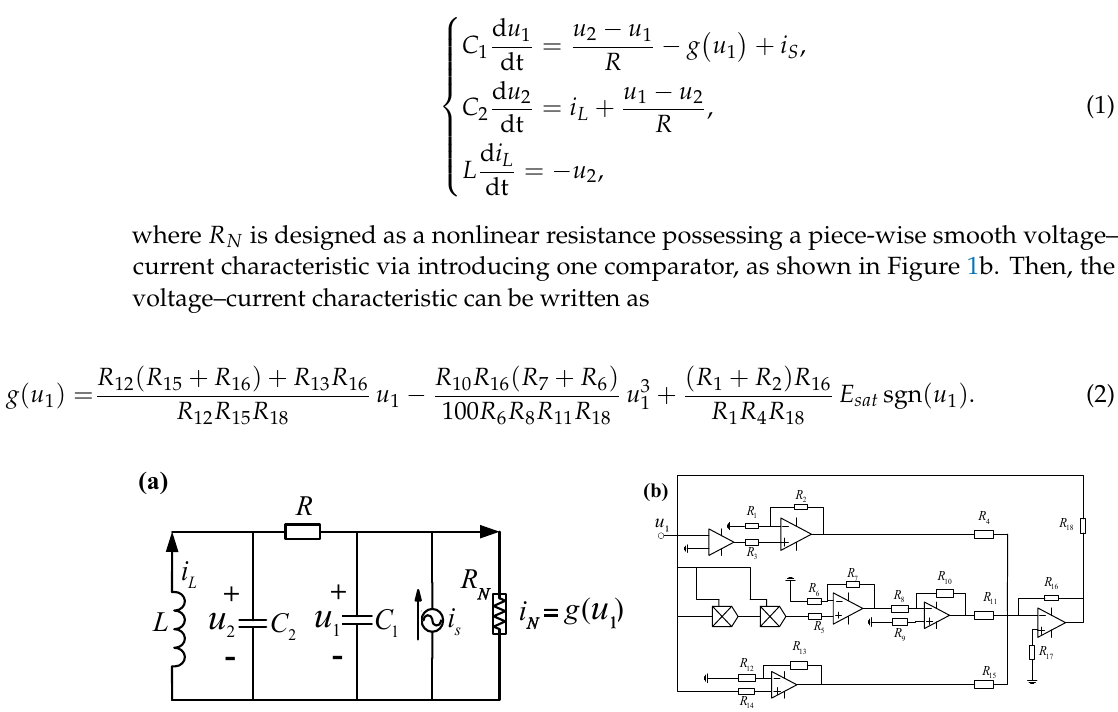
Figure 1. A sketch diagram of Filippov Chua’s circuit. ( a ) Modified Chua’s circuit with a current source i s ; ( b ) the design scheme of the nonlinear resistor R N in ( a